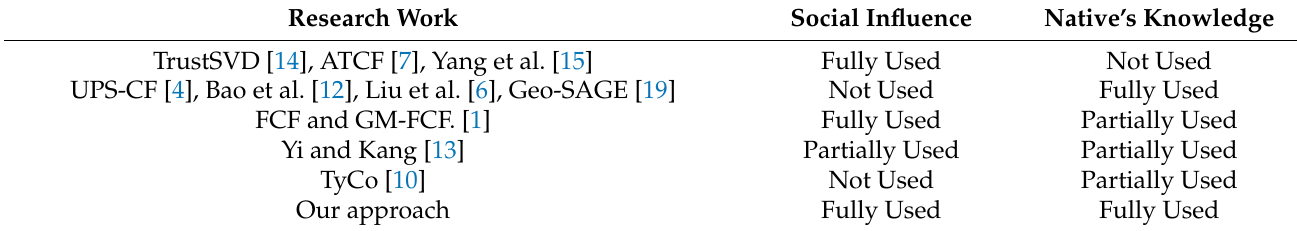
Table 1. A comparison of related work and our approach in terms of using social influence from friends and local experts’ knowledge (natives).